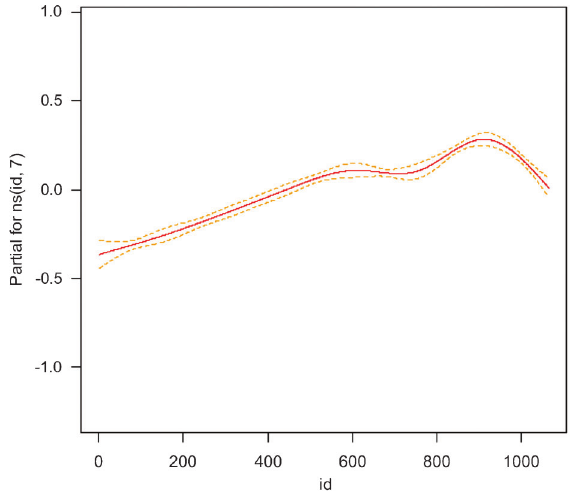
Figure 5. Relative humidity effect graph (4 degrees of freedom).